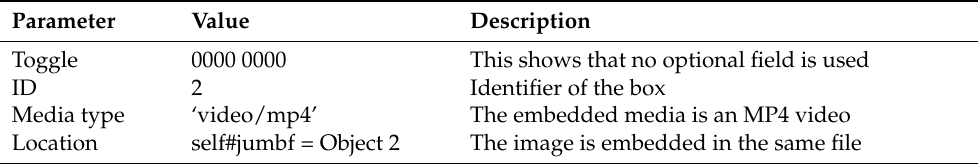
Table A15. Values of the second OBMB parameters for the first